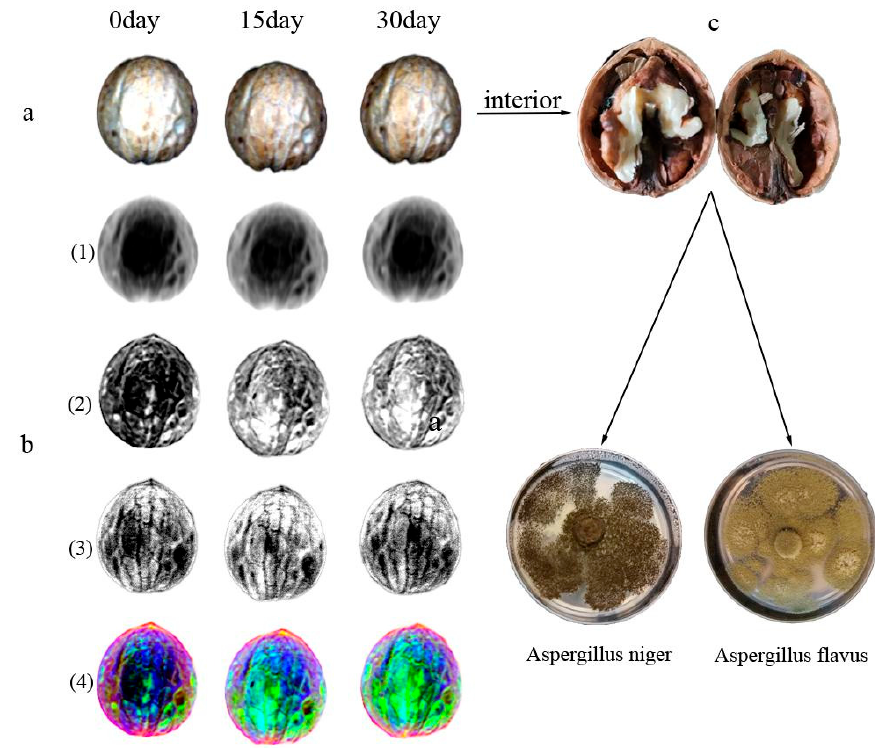
Figure 7. ( a ) Original hyperspectral images of a single walnut sample (R: 638 nm, G:549 nm, B: 456 nm); ( b ) (1)–(3) Score images of PC1–PC3 and (4) pseudo-color images; ( c ) Interior situation of the sample.